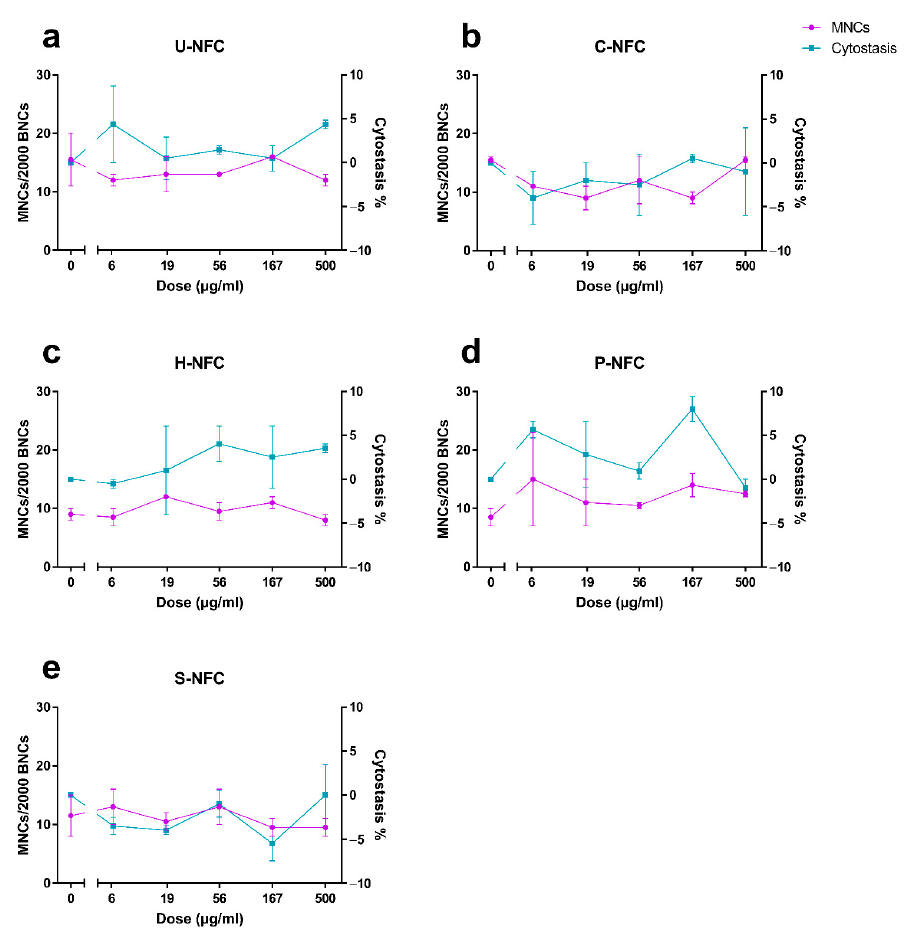
Figure 7. Induction of micronuclei by the nanofibrillated cellulose (NFC) materials. Micronucleus induction was assessed at 48 h exposure to ( a ) U-NFC, ( b ) C-NFC, ( c ) H-NFC, ( d ) P-NFC and ( e ) S-NFC. Purple symbols show the frequency of micronucleated cells in 2000 binucleated cells (MNCs/2000 BNCs). Blue symbols show the percentage of cytostasis. Data are presented as the mean ± standard error of the mean. None of the NFC materials were able to induce an increase in chromosome damage compared with the negative control at any of the tested doses (Figure 7). The positive control, MMC (150 ng/mL), induced a statistically significant increase in the frequency of micronucleated cells over the negative control values in all the experi- ments performed (22.4 ± 3.4-fold increase; p < 0.01; 79.0 ± 1.0% cytostasis), confirming the validity of the experiments.